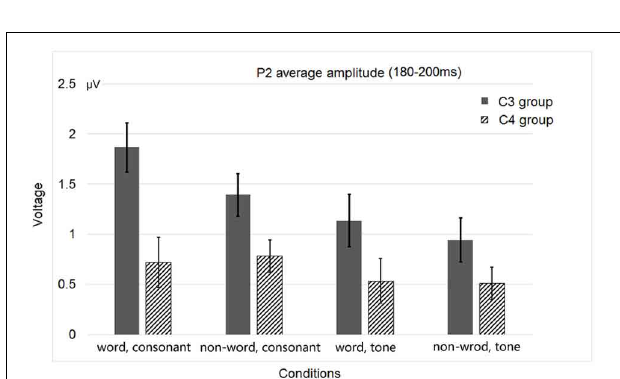
FIGURE 5 | Average P2 amplitudes of the C3 and C4 electrode groups in Experiment